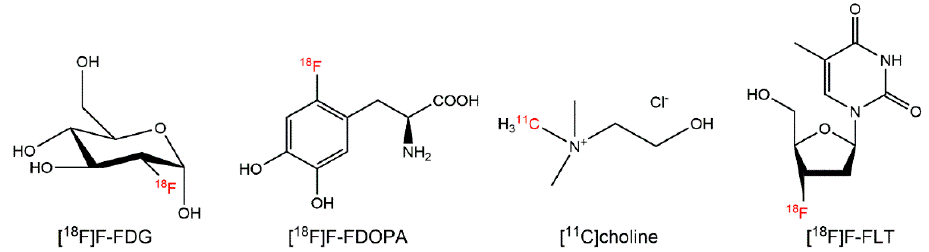
Figure 2. Examples of PET radiopharmaceuticals based on bioactive molecules.